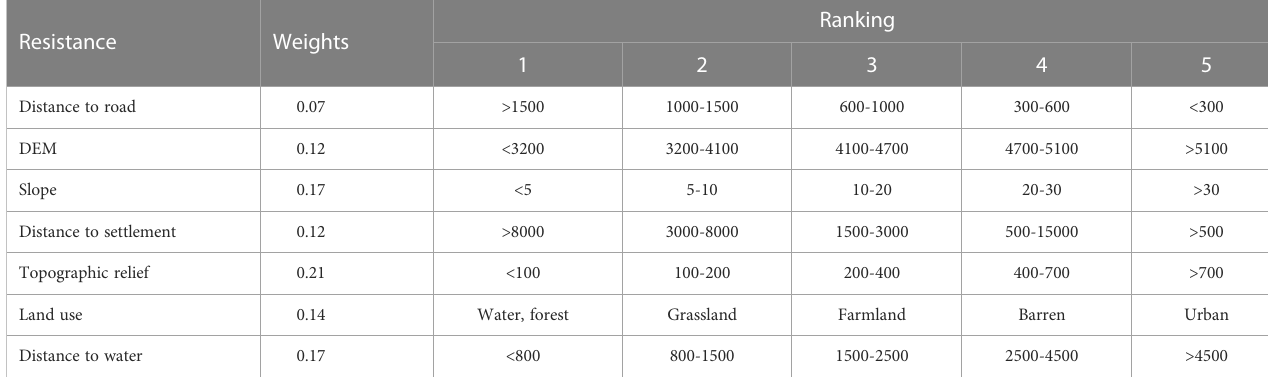
TABLE 2 Resistance factor ranking and weights.